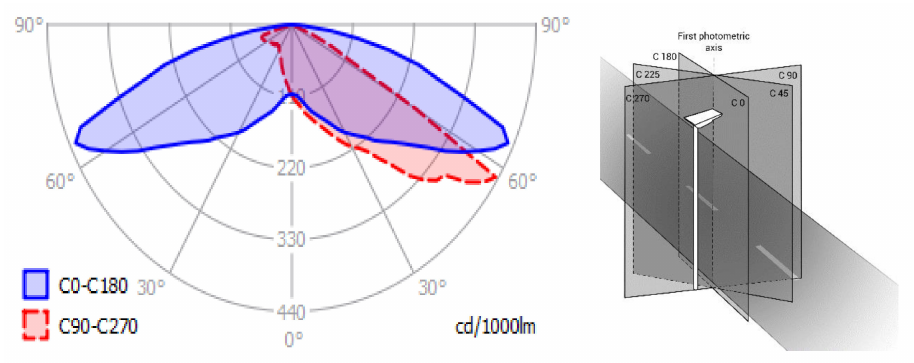
Figure 1. Orientation of selected C-planes for an outdoor lighting